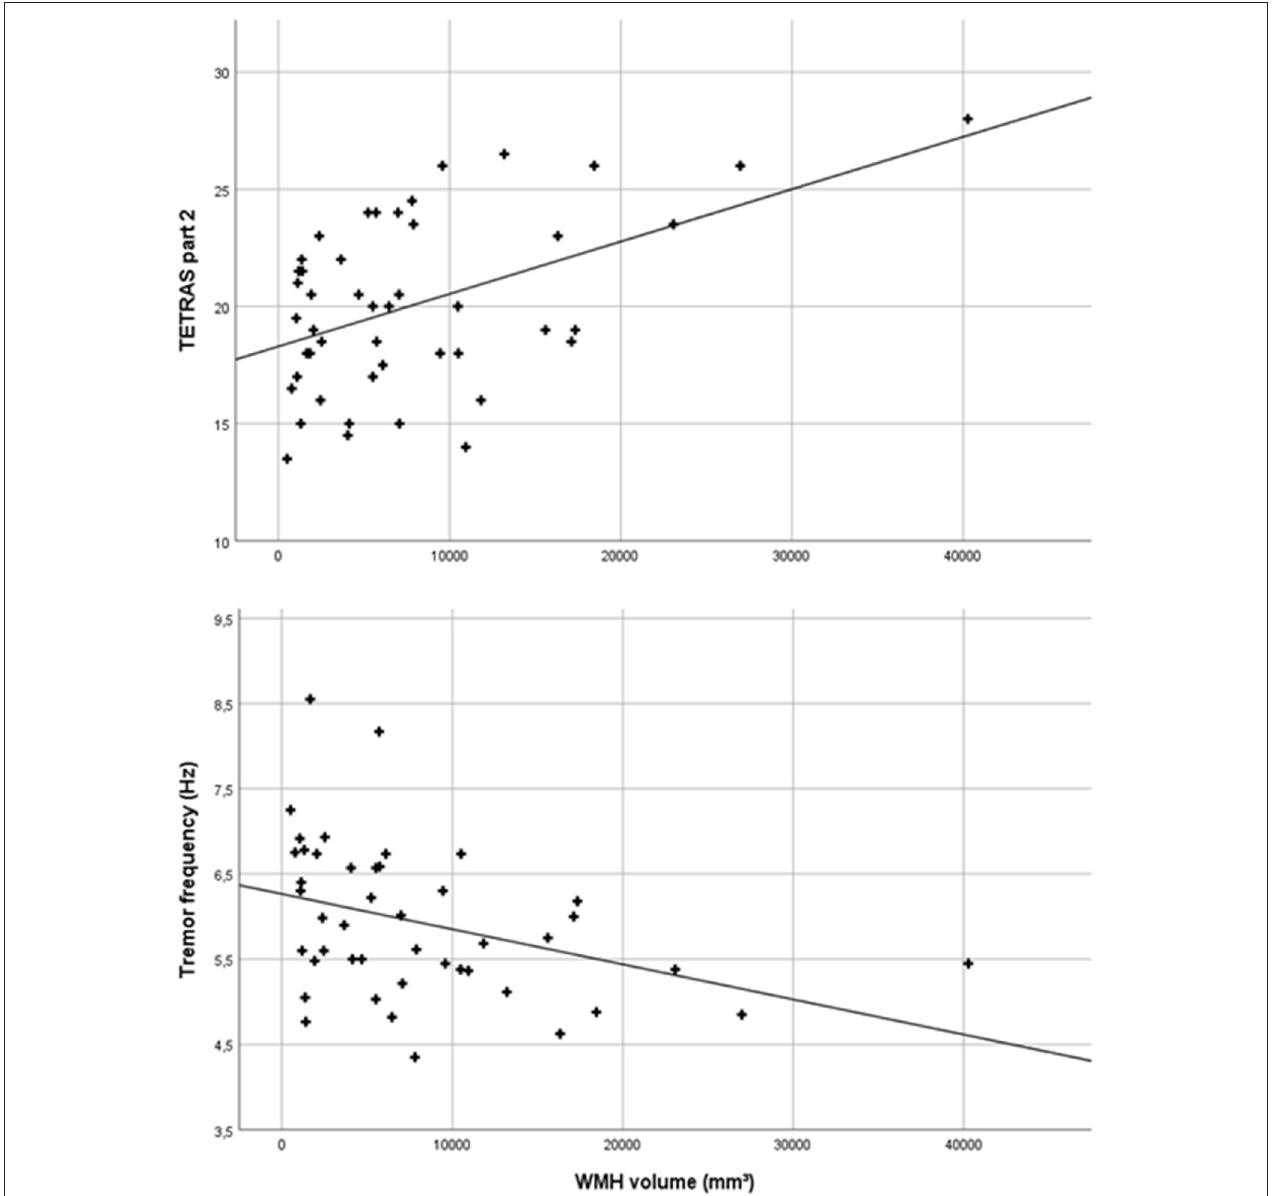
FIGURE 3 | Scatter plot of total white matter hyperintensity (WMH) volumes and Tremor Research Group Essential Tremor Rating Assessment Scale (TETRAS) part 2 scores ( r = 0.482, p = 0.001) and mean accelerometric tremor frequencies ( r = − 0.372, p = 0.012) of essential tremor (ET) patients.